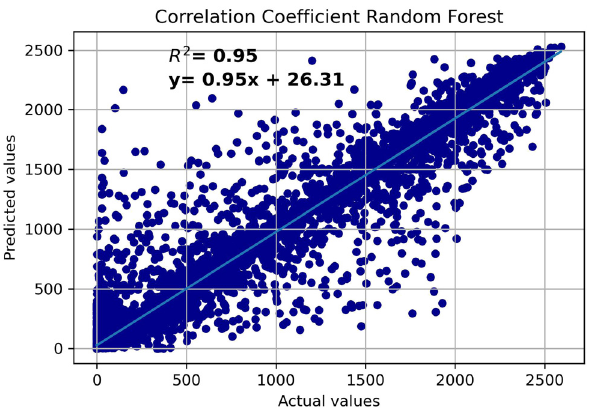
Figure 4: The scattered plot between the actual and predicted values of the Random Forest